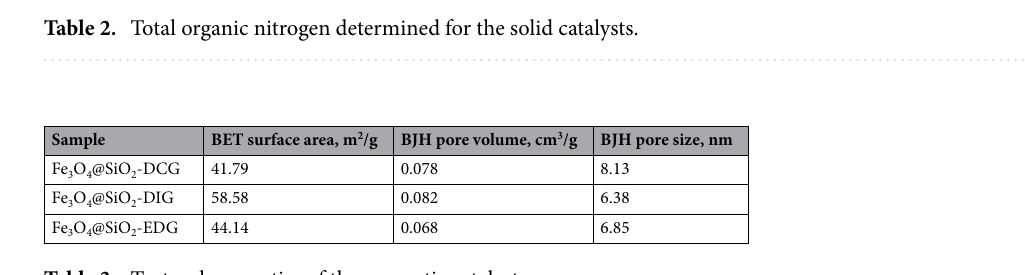
Table 3. Textural properties of the magnetic